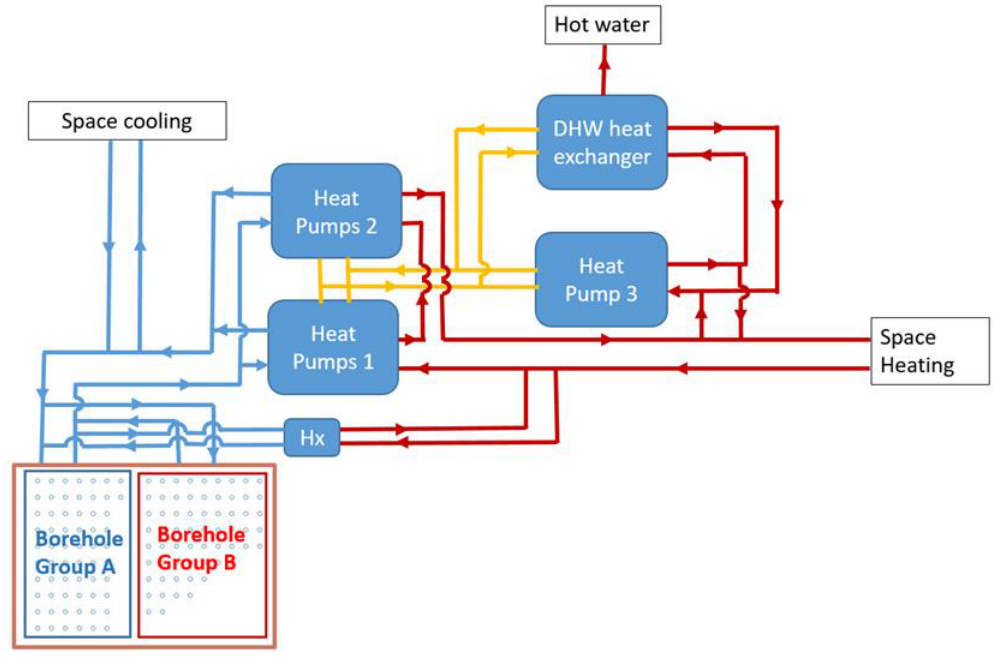
Figure 2. Schematic of the GSHP (Reproduced from [54], Infroma UK Limited: 2020).